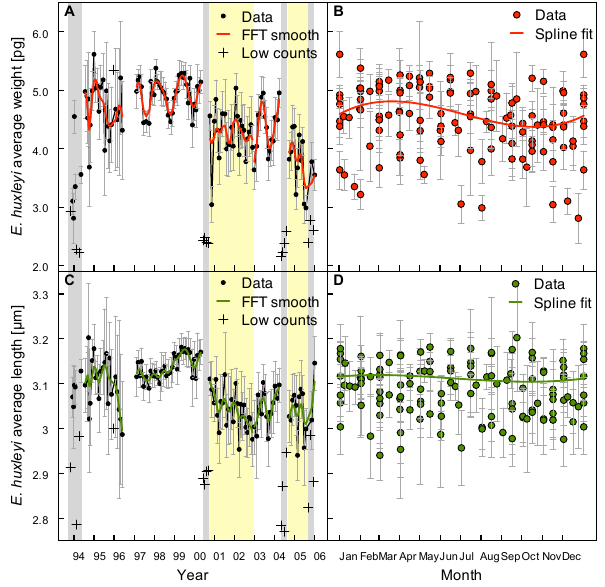
Figure 2. Emiliania huxleyi mean coccolith length and weight over the sediment trap deployment period (A, C) and on a composite year (B, D) . Long-term trends, seasonal variability, periods with extremely low average weight (grey shade) and periods with re- duced/changed seasonality (yellow shade) are